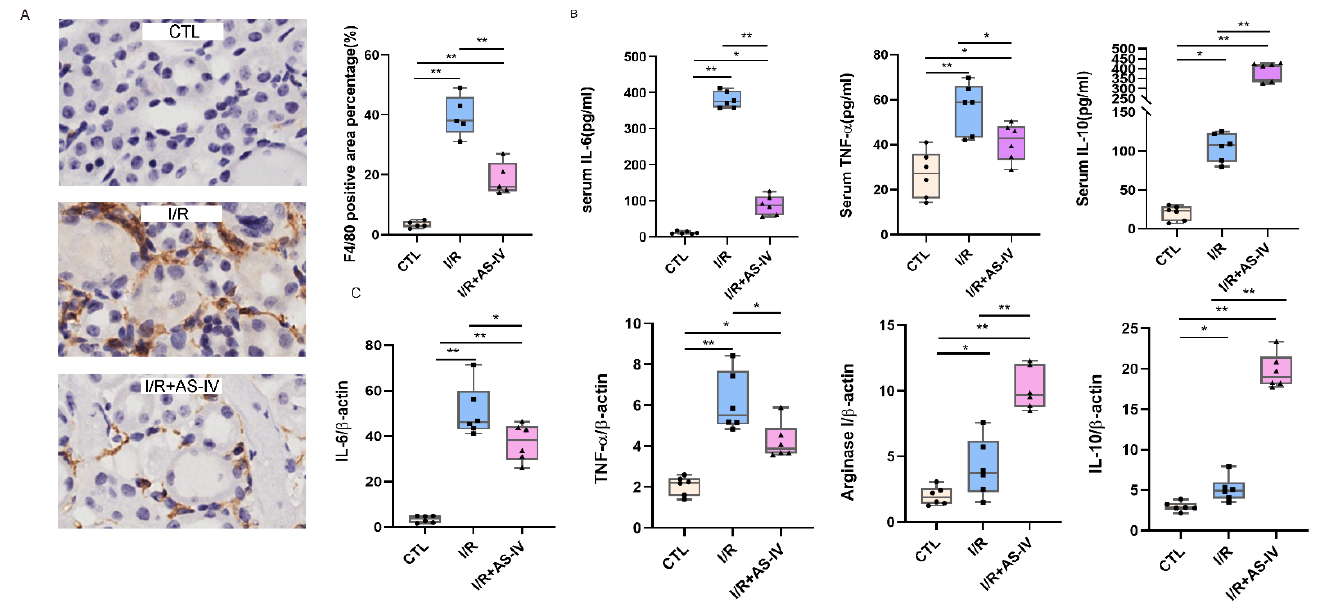
Figure 3. AS-IV inhibits macrophage infiltration and promotes M1 to M2 phenotypic switching 24 h after I/R. ( A ) Immunohistochemistry staining of F4/80 and quantification score of CTL, I/R, I/R+AS-IV groups (magnification ×400). The brown areas represent positive expression of F4/80. ( B ) Serum IL-10, TNF- α, and IL -6 levels 24 h after ischemia-reperfusion determined by ELISA. ( C ) Relative mRNA levels of IL-6, TNF- α, Arginase I, and IL -10 in kidney tissues. n = 6 in each group, * p < 0.05, * * p < 0.01.